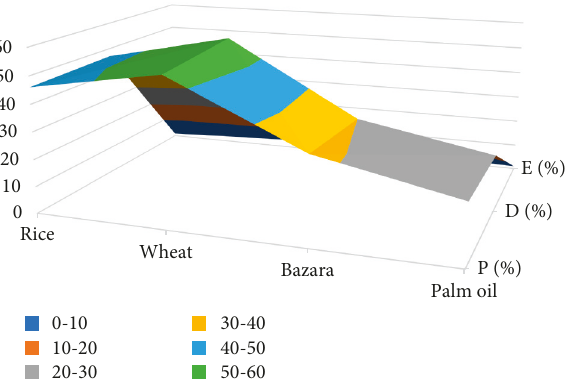
Figure 12: ARIMA forecast on different commodity.